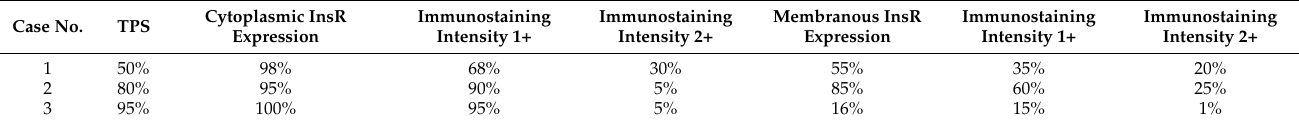
Figure 8. Colocalization of cytoplasmic (activated) insulin receptor and PD-L1 in human PDAC tissue. ( A ) Consecutive tissue sections of FFPE tissue from human PDAC samples were submitted to conventional immunostaining using an InsR and a PD-L1 antibody. Strongly membranous PD-L1-expressing areas regularly matched those with cytoplasmic InsR expression—two of which are depicted (marked by the ovals) and weaker PD-L1-expressing areas matched membranous InsR staining. Strongly (2+) InsR-expressing tumor vasculature is observed in the proximity (arrowheads). Original magnification: 200 × ( B ). To validate PD-L1 and InsR colocalization in the context of tumor cells (arrow) and vasculature (arrowhead), immunofluorescence staining was performed. PanCK and CD31 are colored in green and turquoise, and InsR and PD-L1 are shown in red and blue, respectively (artificial color rendering). Images of InsR and PD-L1 expression are digitally merged to confirm colocalization (yielding purple). Original magnification: 100 × . Table 1. Characterization of PDAC specimens with tumoral PD-L1 and InsR expression. PD-L1 expression in tumor cells was evaluated using the tumor proportion score (TPS), which is defined as the percentage of cancer cells showing membranous PD-L1 staining. Cytoplasmic and membranous InsR expression in tumor cells were separately evaluated with regard to the intensity of immunostaining (0 = no evidence of staining; 1+ = weak staining; 2+ = strong staining). The proportion of InsR-expressing tumor cells within a given sample is given in percent (%).